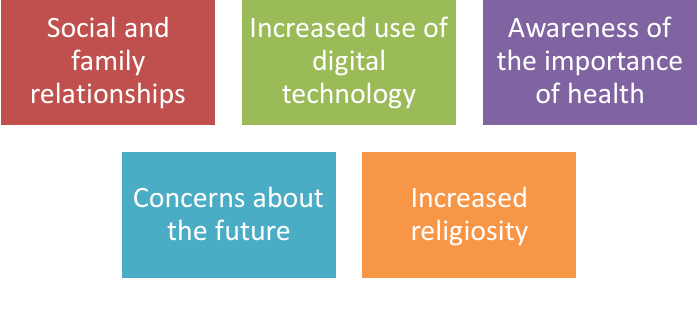
Figure 1: Impact of Covid-19 on Gen-Z Life ; Source: Processed Data